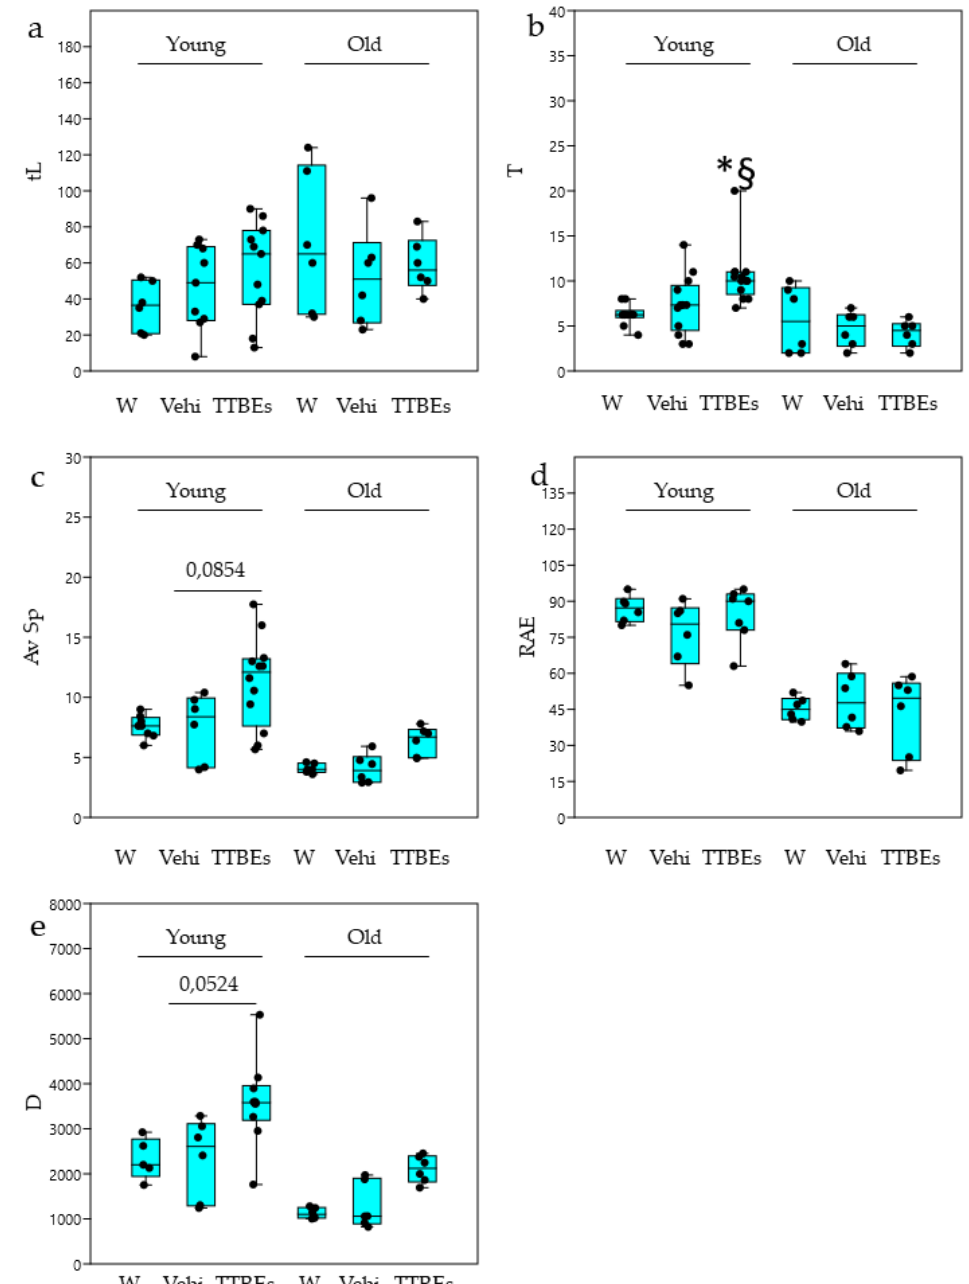
Figure 8. Light Dark test in young and old male mice: effects 21 days of dietary integration with vehicle, TTBEs respect to water. Behavioral skills were quantified as ( a ) time in light (tL), ( b ) n° of transitions (T), ( c ) average speed (Av Sp), ( d ) exploration rate % (RAE) and ( e ) total distance (D). Data represent the mean ± S.E.M. ( n = 9 (W), 12(Vehi) 12 (TTTBEs) young and ( n = 6 (W), 6 (Vehi) 6 (TTTBEs) old mice analyzed in three different trials. Statistical analysis was performed by applying ANOVA followed by the Tukey’s multiple comparison test. * p < 0.05 water; § p < 0.05 vs. vehicle.